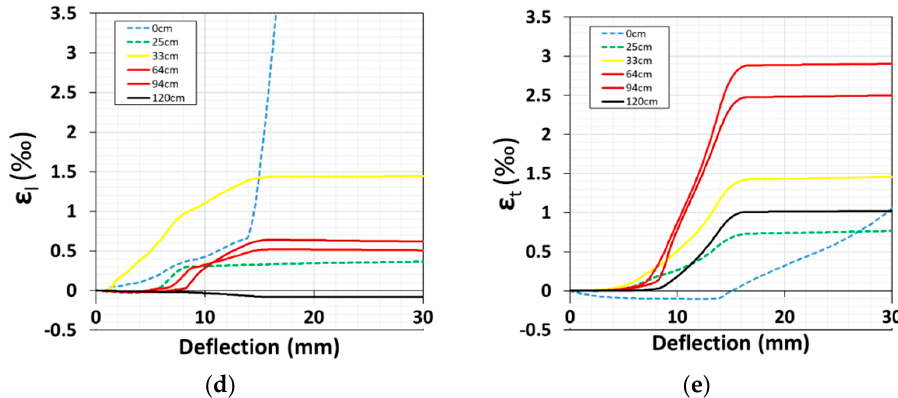
Figure 10. Strains. ( a ) Monitoring locations. ( b ) Shear strain-transverse strain plots. ( c ) Longitudinal strain-transverse strain plots. ( d ) Longitudinal strain-deflection plots. ( e ) Transverse strain-deflection plots.